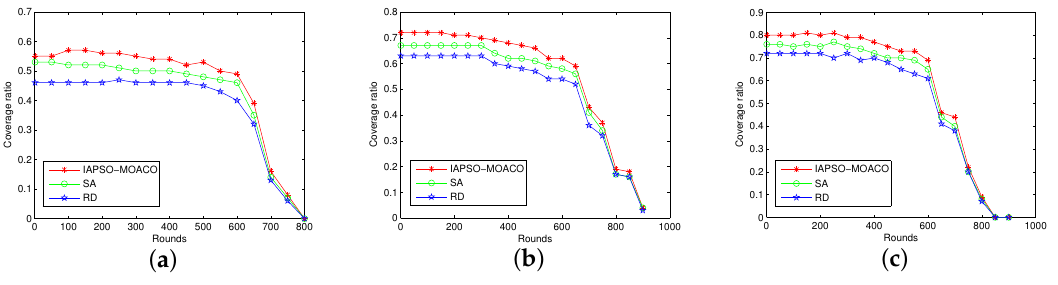
Figure 4. Comparison in terms of coverage ratio with 100 to 200 nodes. ( a ) 100 nodes with 6 cluster heads; ( b ) 150 nodes with 9 cluster heads; ( c ) 200 nodes with 12 cluster